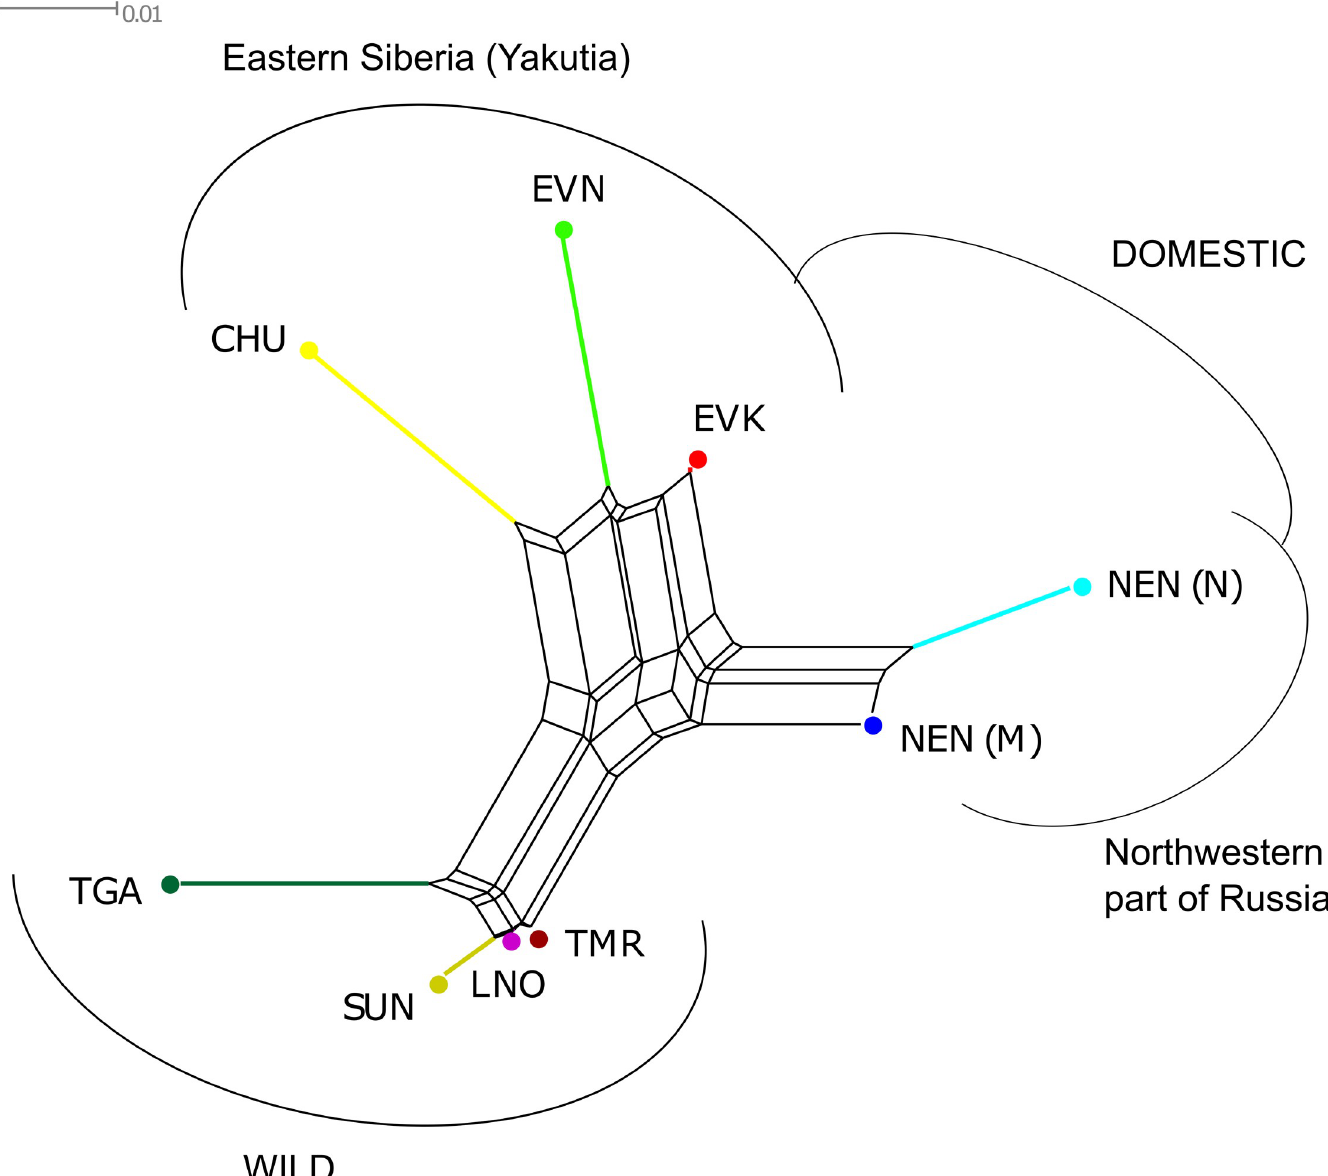
Fig 2. Neighbor-Net tree based on pairwise F ST values between reindeer populations. Note: NEN_M–Nenets breed of the Murmansk region; NEN_N–Nenets breed of the Nenets Autonomous district; EVK–Evenk breed, EVN–Even breed; CHU–Chukotka-Khargin breed; and TMR–Taymyr Peninsula, LNO–Leno-Olenek, SUN– Sundrun, and TGA–taiga (boreal forest) wild